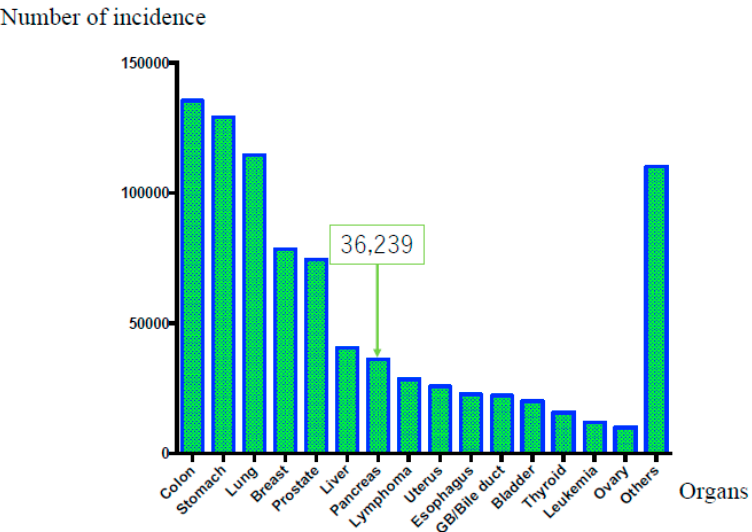
Figure 1. Overall cancer incidence rate according to affected organ (in Japan). The overall cancer